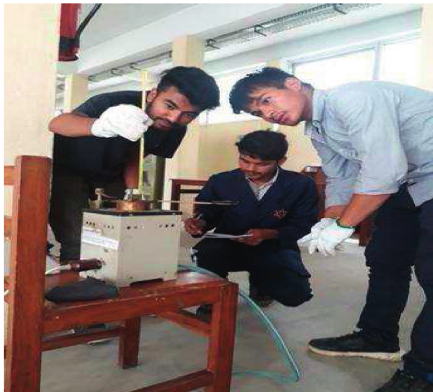
Figure 8: Thermal resistance test.